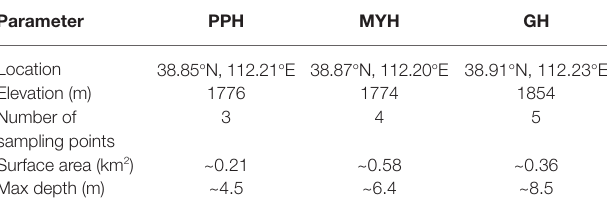
TABLE 1 | Brief description of the sampling sites in the Ningwu subalpine lakes.